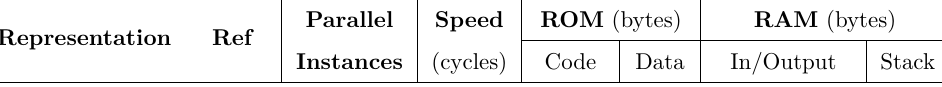
Table 3: Implementation results on E31 RISC-V processor for various bitsliced represen- tations of AES . For encryption routines, speed is expressed in cycles per block and the RAM requirements for the round keys are enclosed in parentheses. Emboldened and italic fonts refer to unrolled and non-unrolled implementations,